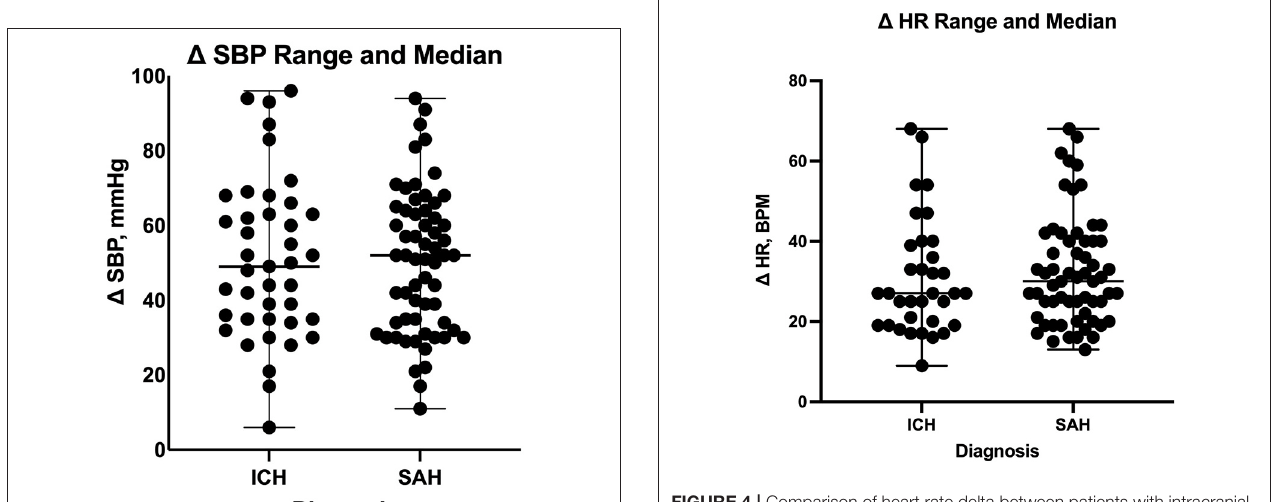
FIGURE 4 | Comparison of heart rate delta between patients with intracranial hemorrhage and those with subarachnoid hemorrhage during the transition process. HR, heart rate; ICH, intracranial hemorrhage; SAH, subarachnoid hemorrhage. − 0.258–0.145). The data for HR variability are shown